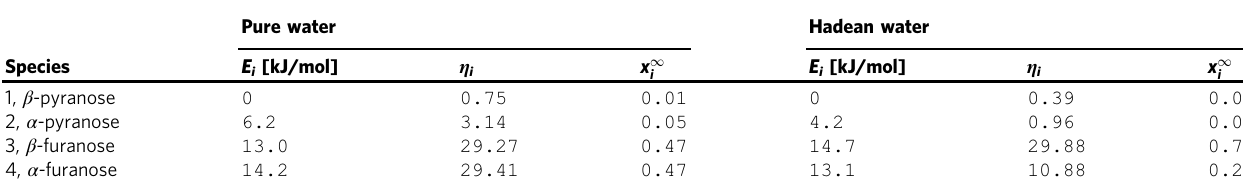
Table 1 Thermodynamic parameters describing the equilibrium of D-ribose isomerisation in solution at fi xed temperature and pressure as estimated by fi tting the equilibrium theory (2) to 13 C NMR data.